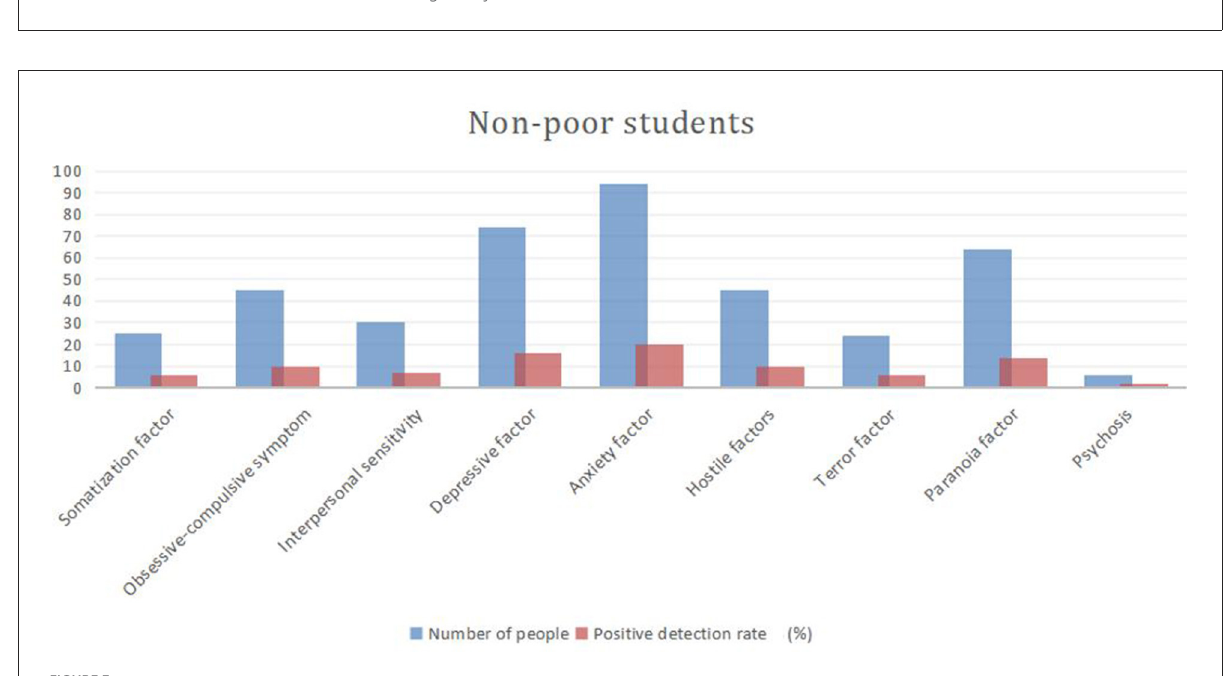
FIGURE3 Positive detection rates of SCL-90 factors among non-poor